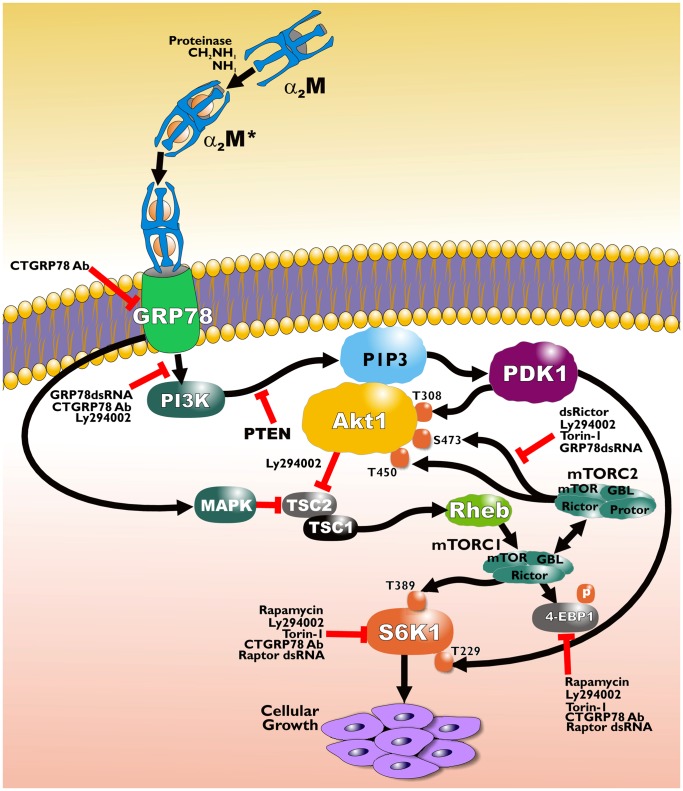
A model summarizing the results of this study.The abbreviation CTGRP78 Ab refers to antibodies directed against the COOH-terminal domain of GRP78. S6K is S6-Kinase.